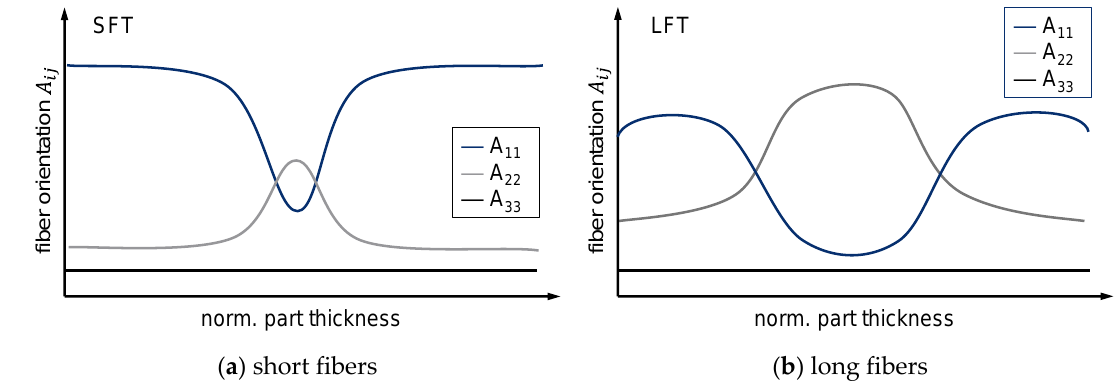
Figure 6. Characteristic fiber orientation distributions along the parts thickness in discontinuous fiber reinforced plastics.